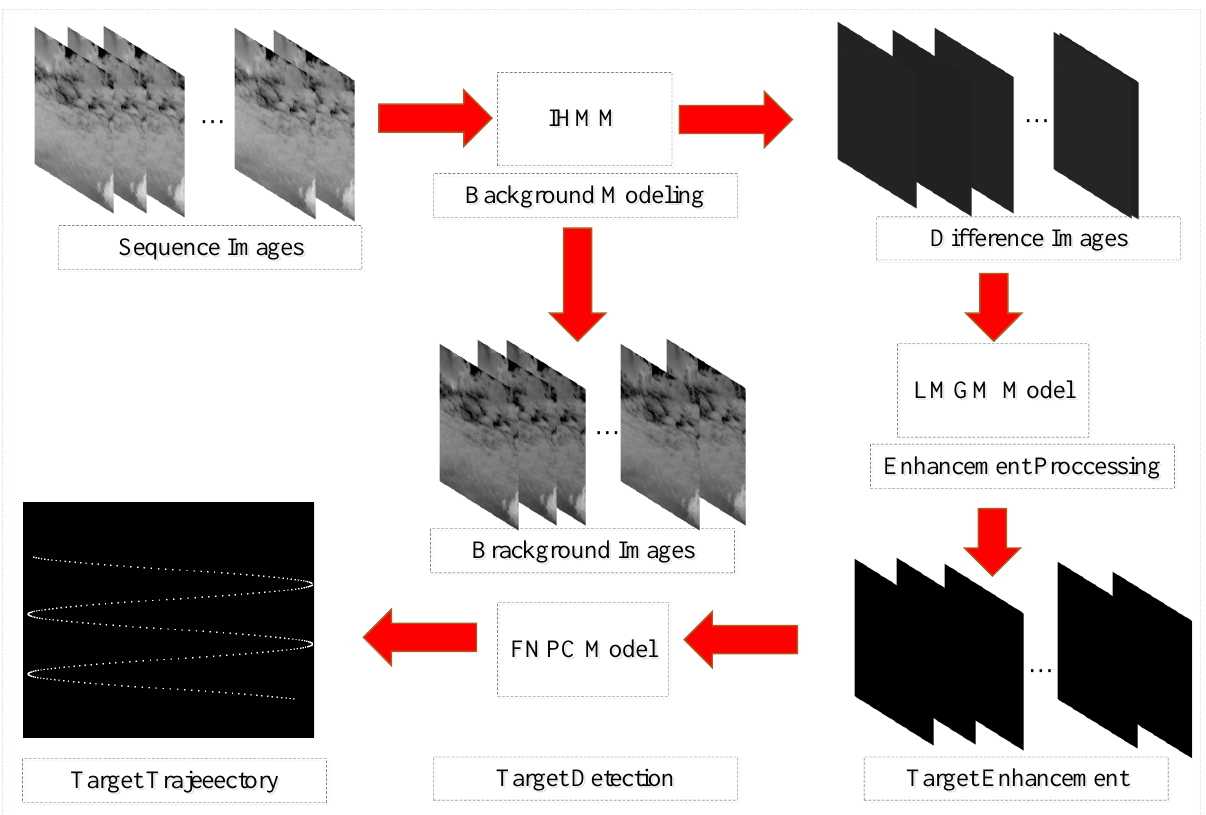
Figure 3. Overall flow chart of detection